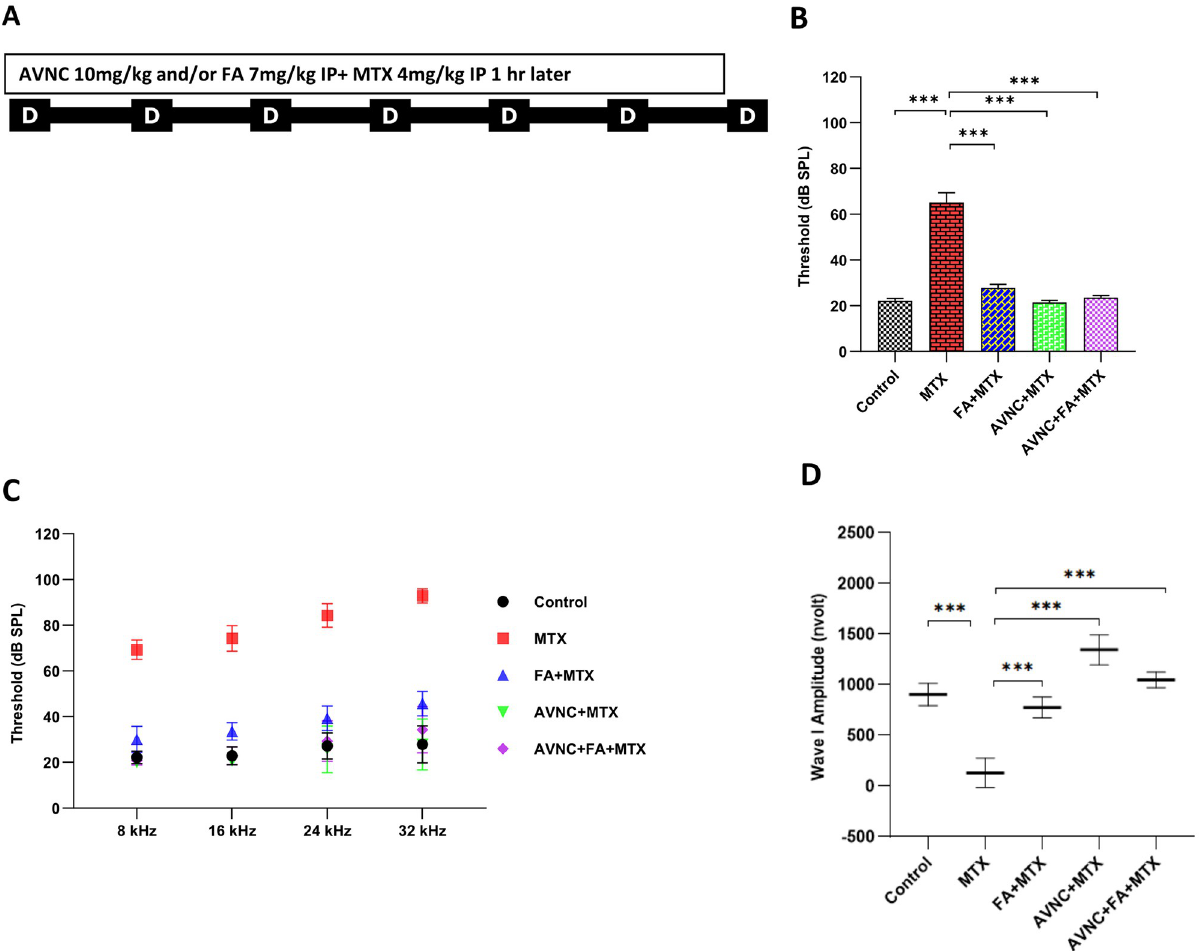
Fig 2. AVN-C and FA preserve hearing from MTX ototoxicity by ABR. A. Schematic diagram of drug treatment schedule and timeline. AVN-C and FA were injected intraperitoneally one hour before MTX administration for seven consecutive days. B. ABR wave I amplitude in 90 dB SPL. Wave I amplitude was defined as the magnitude difference between the first positive peak and the next negative peak. MTX treatment decreased the wave I amplitude, whereas treatment with AVN-C and FA reversed this decrease ( ��� p < 0.001; one-way ANOVA). AVN-C treatment outperformed the rescue of wave I amplitude by FA as well as the combination treatment with AVN-C and FA. C (Click ABR) and D (Tone burst ABR) show that one month after drug treatment, the hearing thresholds in ABR increased in the MTX-treated group, whereas AVN-C and FA treatment reduced hearing thresholds ( ��� p < 0.001; one-way ANOVA). n = 7 mice per